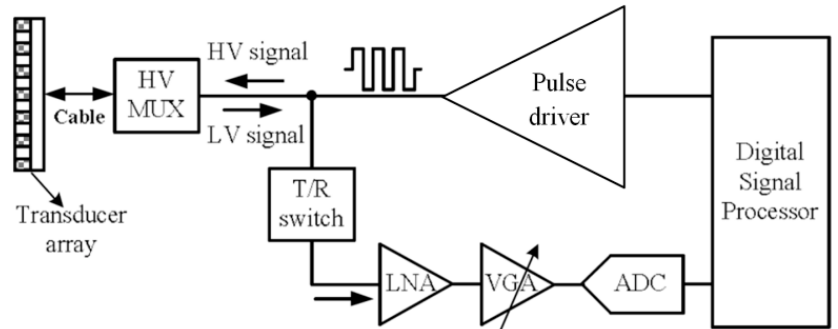
Figure 4. A typical biomedical ultrasound actuator/receiver system (HV MUX presents high-voltage multiplexer, LV and HV signals present low-voltage reflected and high-voltage excited signals, respectively, T/R switch presents the transmit/receive switch, LNA is the low noise amplifier, VGA is the variable gain amplifier, and ADC is the analog-to-digital converter).